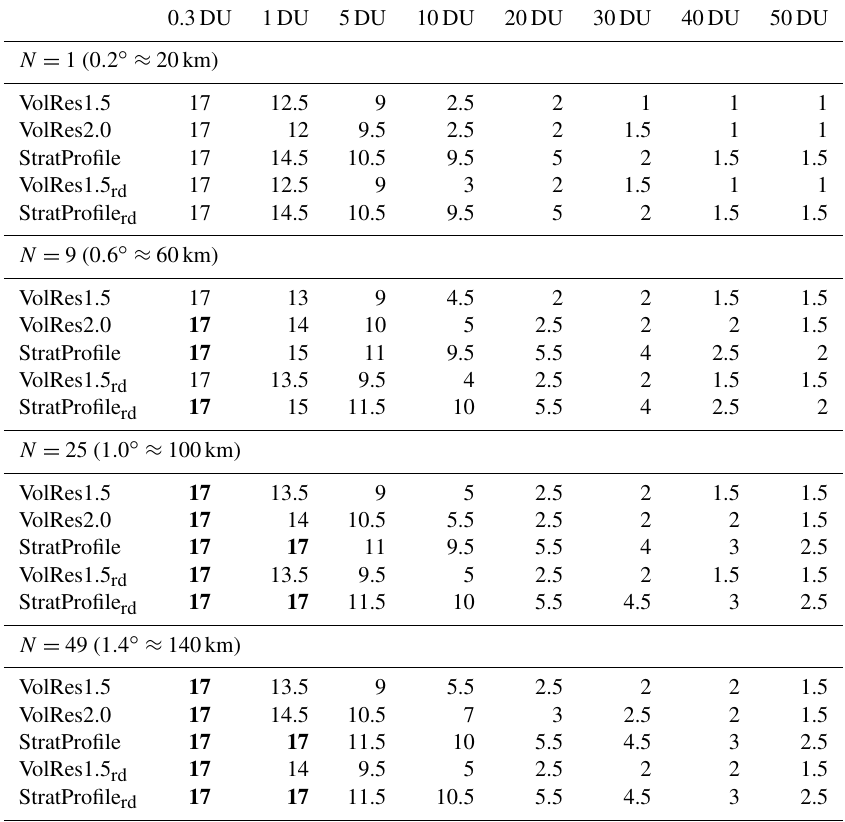
Table A1. The FSS-based timescales estimates for which the NAME simulations have skill compared to TROPOMI at the given spatial resolution N . The given values represent the number of days after start of eruption (rounded by 0.5d) where the FSS comparison between the NAME simulations and the TROPOMI retrievals drops below 0.5 for various neighbourhood N sizes (value in brackets shows the corresponding model resolution for which the values would be valid), maximum included vertical column density contours and NAME simulations. When calculating the daily FSS value, we only include overpasses where the satellite-retrieved total mass was above 0.2Tg to remove noise. When the model still has skill FSS > 0.6 on the last day where we could determine FSS (17d), we represent this with a bold number, indicating that the value could be higher than what is presented